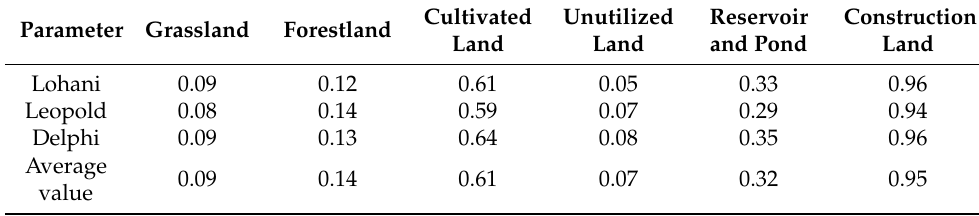
Cultivated Unutilized Reservoir Construction Land Land and Pond Land